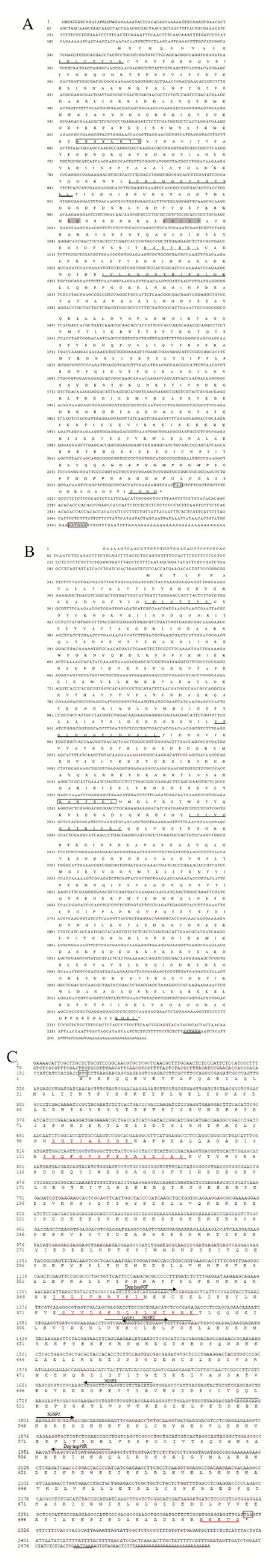
Figure 1. Nucleotide and deduced amino acid encoding region of TpHSP70-1 ( A ), TpHSP70-2 ( B ) and TpHSP90 ( C ). Signature sequences of TpHSP genes are marked with